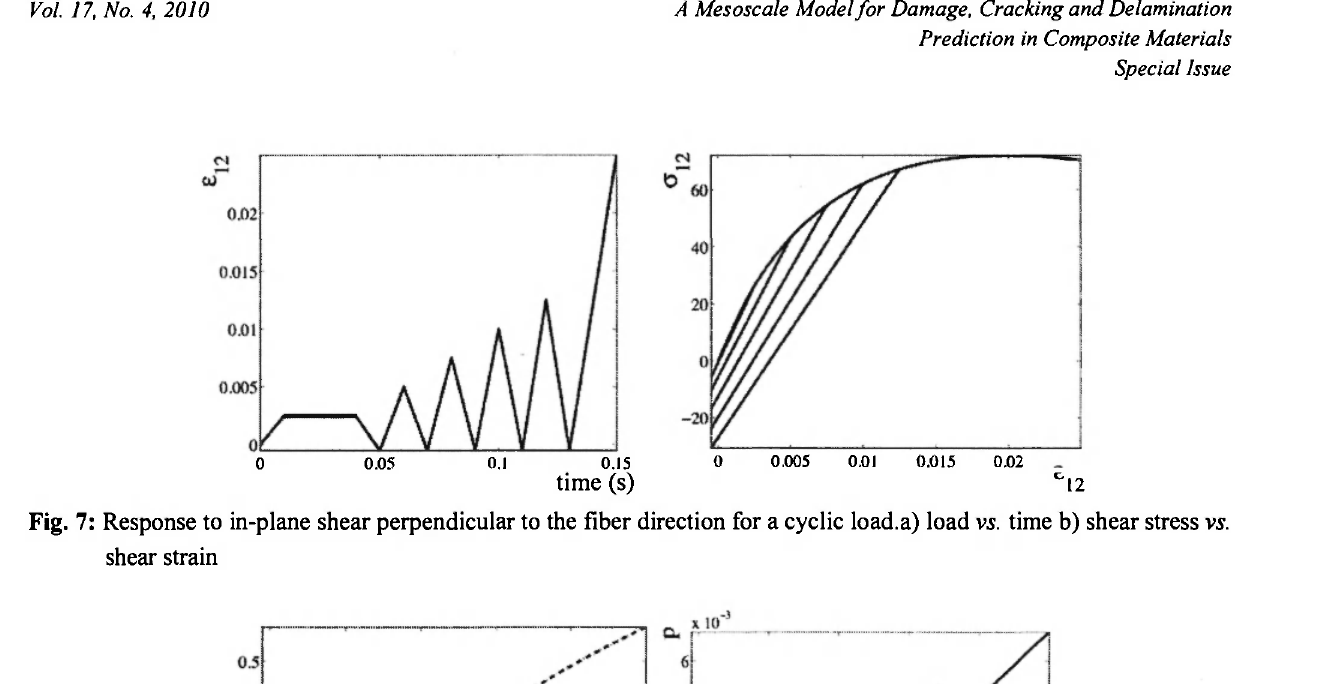
Fig. 7: Response to in-plane shear perpendicular to the fiber direction for a cyclic load.a) load vs. time b) shear stress vs. shear strain